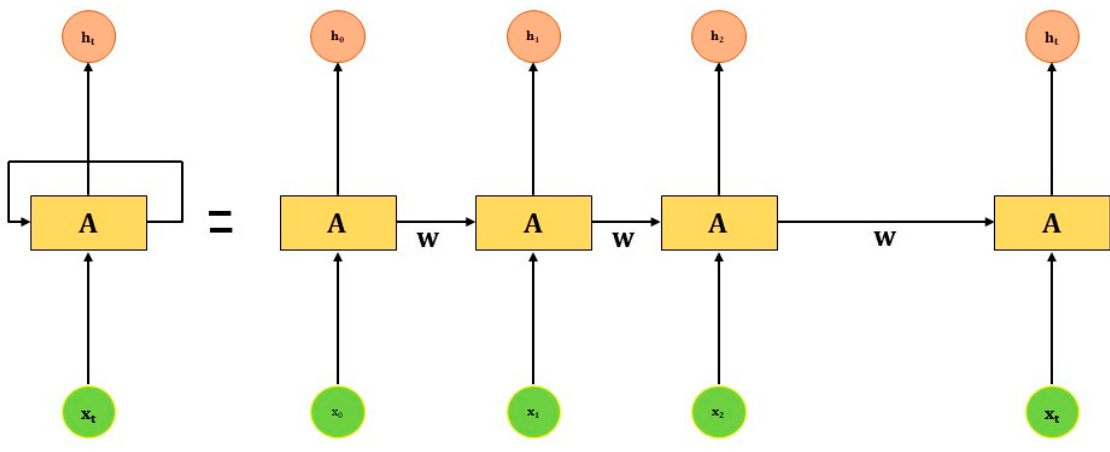
Figure 6. The architecture of RNN.